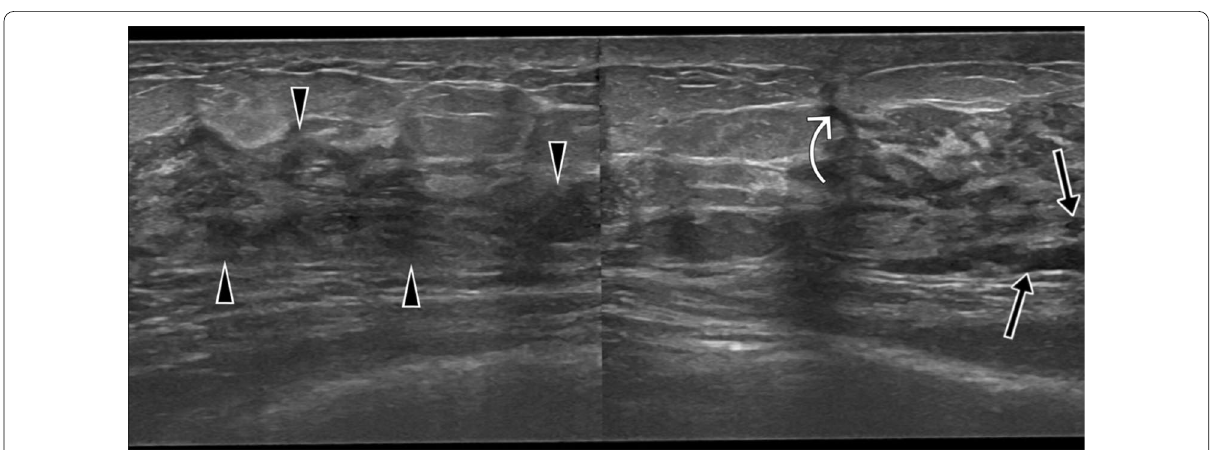
Fig. 6 Ultrasound images of a 33-year-old female. Parenchymal diffuse hypoechoic coarsening in the left breast (arrowheads), small fluid collections (arrows), and sinus tract (curved arrow). BIRADS 4